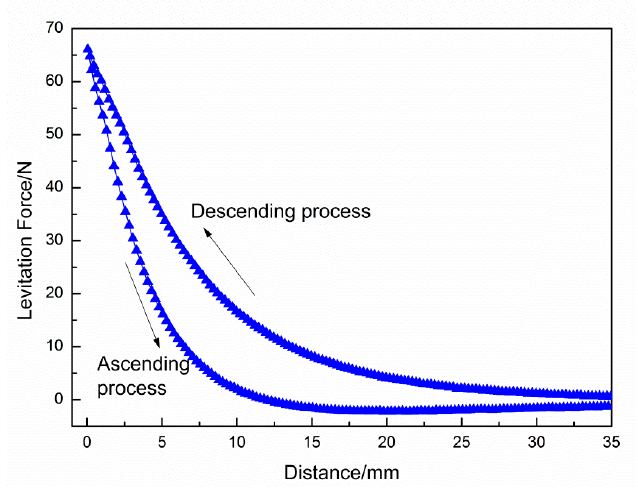
Figure 4. Levitation force–distance z curves of the drilled SmBCO bulk sample under zero-field cooled state at 77 K.